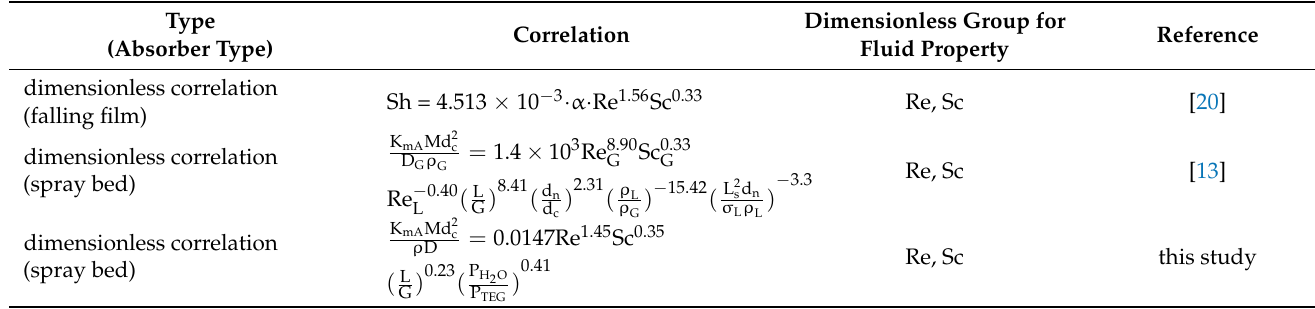
Table 2. Recent studies discussed on mass transfer correlation in the